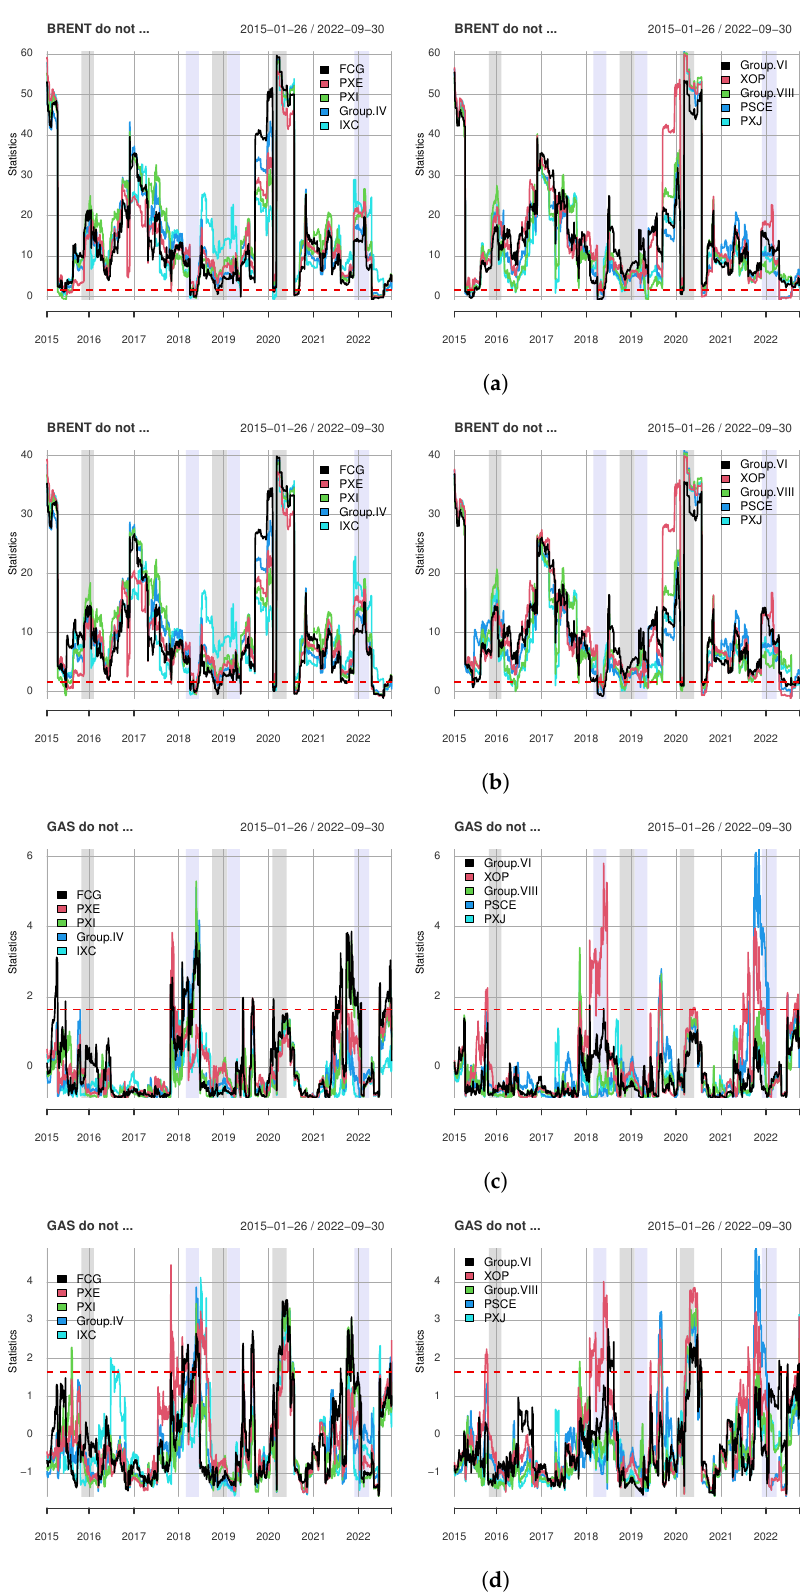
Figure A6. Rolling Hong tests between crude oil, gas and ETFs (causality-in-variance) for different integer M . ( a ) M = 3. ( b ) M = 10. ( c ) M = 3. ( d ) M =